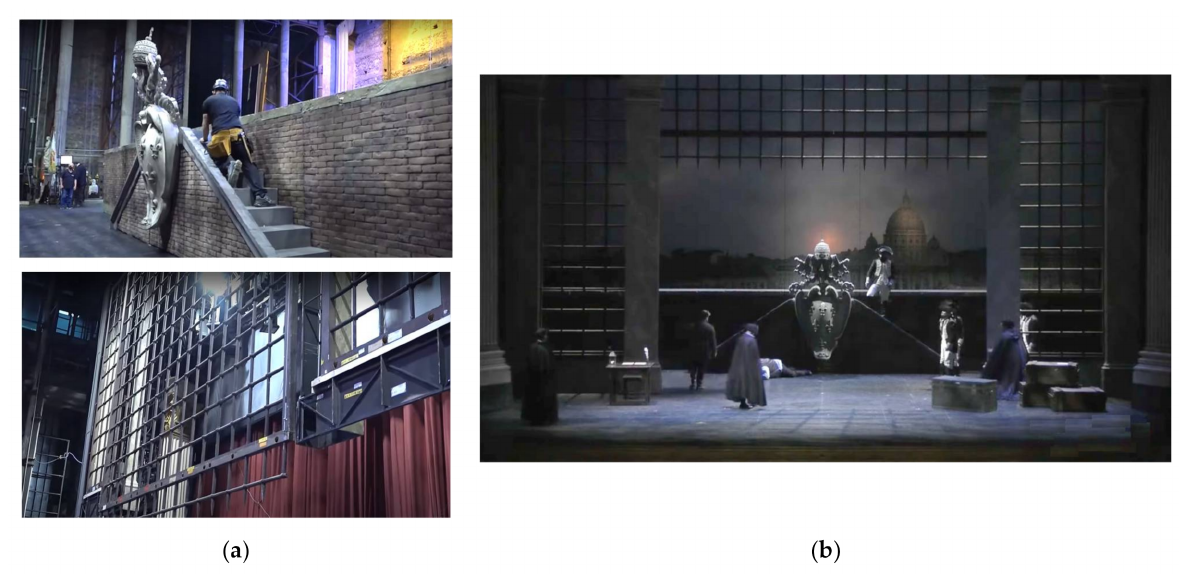
Figure 10. Act III of Tosca at the Teatro Massimo of Palermo (2022): installation ( a ) and final scenery during the performance ( b ).